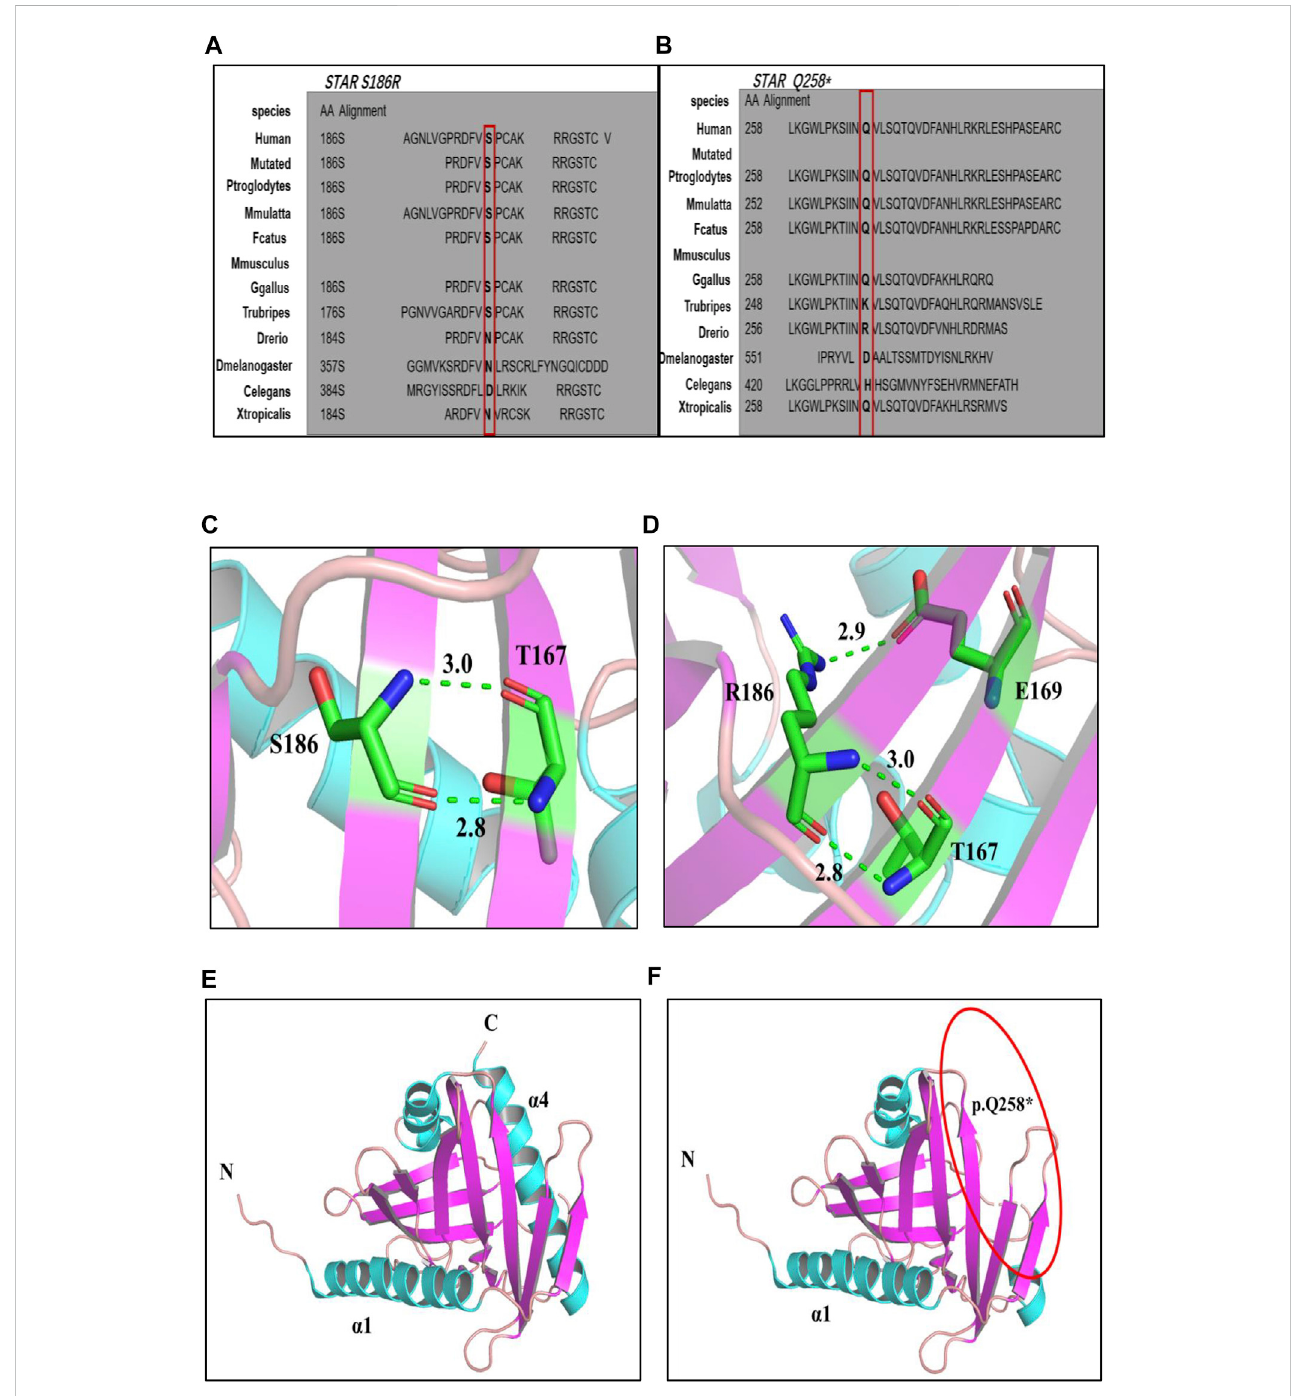
FIGURE 2 (A, B) : Multiple alignment of the STAR protein sequence in different species, indicating conservation of the residues STAR p. S186R (A) and p. Q258* (B) affected by these mutations. (C – F) 3D structures of wild-type and mutant STAR proteins. (C, D) Wild-type and p. S186 R STAR protein; (E, F) Wild-type and p. Q258*STAR protein. Notes: helix: sky blue; β -sheet: purple; α -loop: pink; C atom: green; H atom: gray; N atom: ocean blue; O atom: red; H2O: orange; hydrogen bond: green dotted